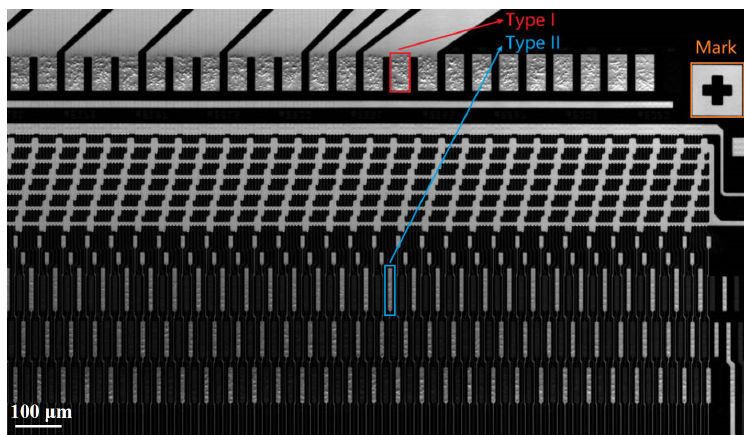
Figure 9. The local image of LCD module containing bump and mark